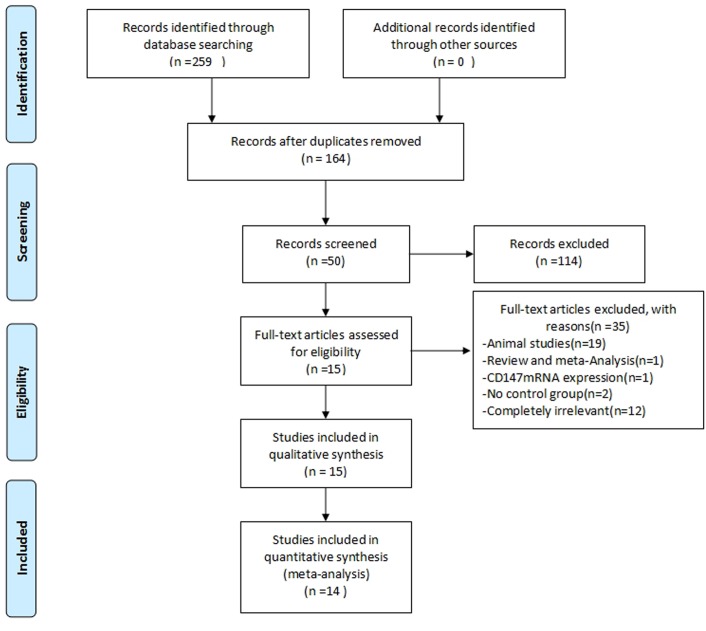
Flow diagram of the literature filtering,14 studies are identified for analysis.